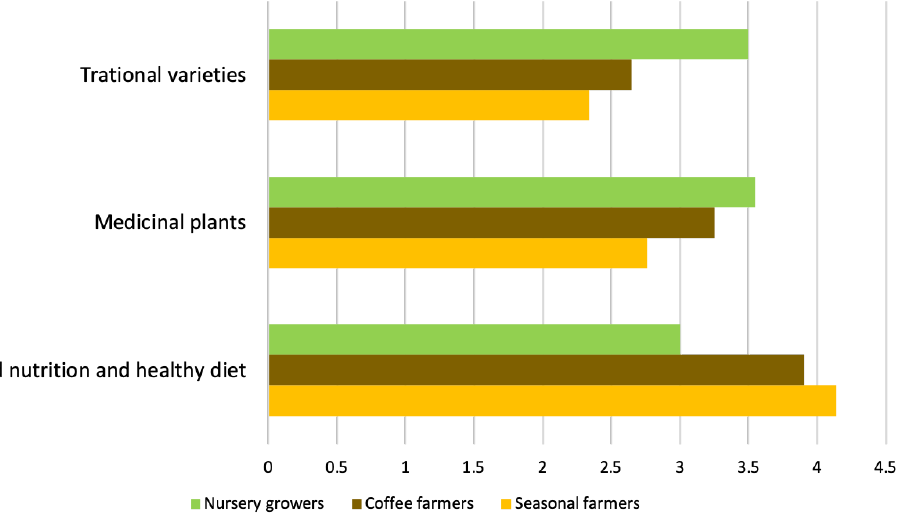
Figure 3. Farmer perceptions about the importance of medicinal plants, traditional plant varieties, and balanced diets.